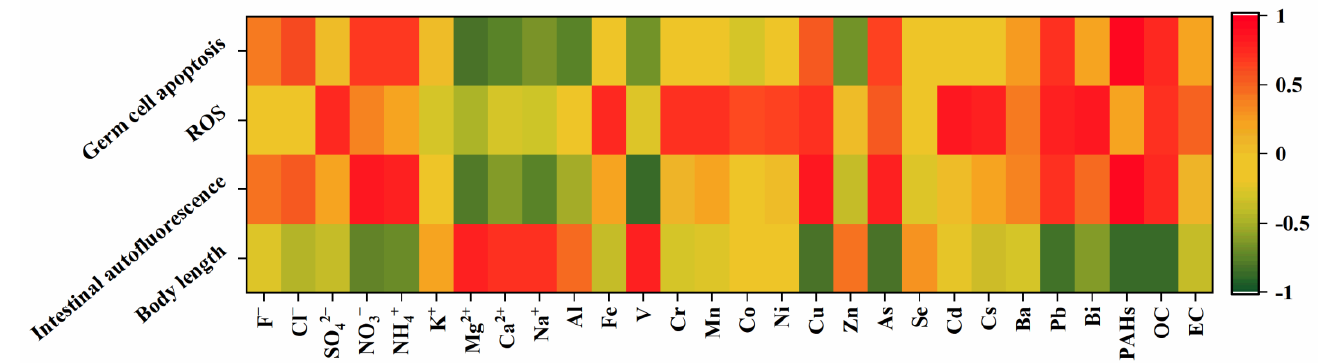
Figure 6. Heat map of correlation coefficients between body length/intestinal fluores- cence/ROS/germ cell apoptosis and PM